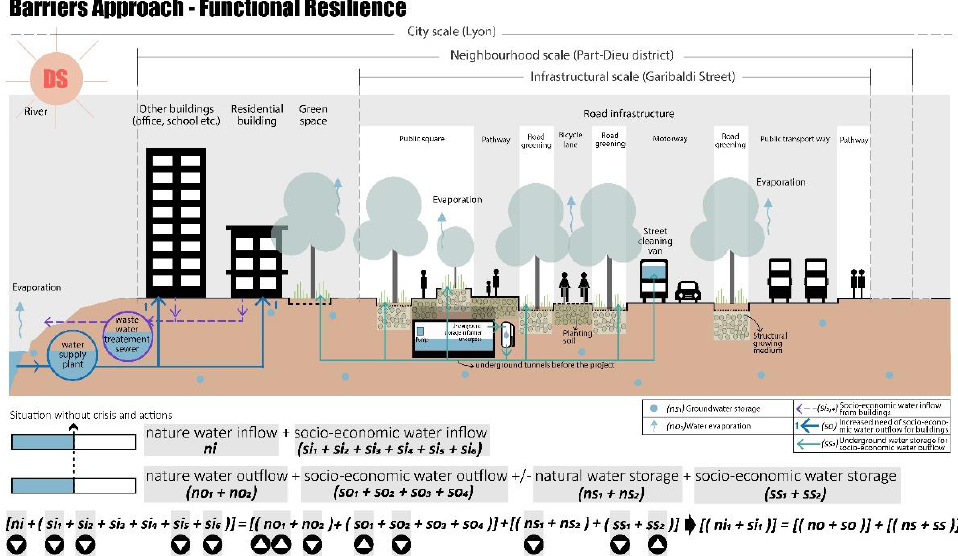
Figure 8. Inside the “barrier”, functional resilience drought scenario, realised by authors, adapted from TDAG [101].